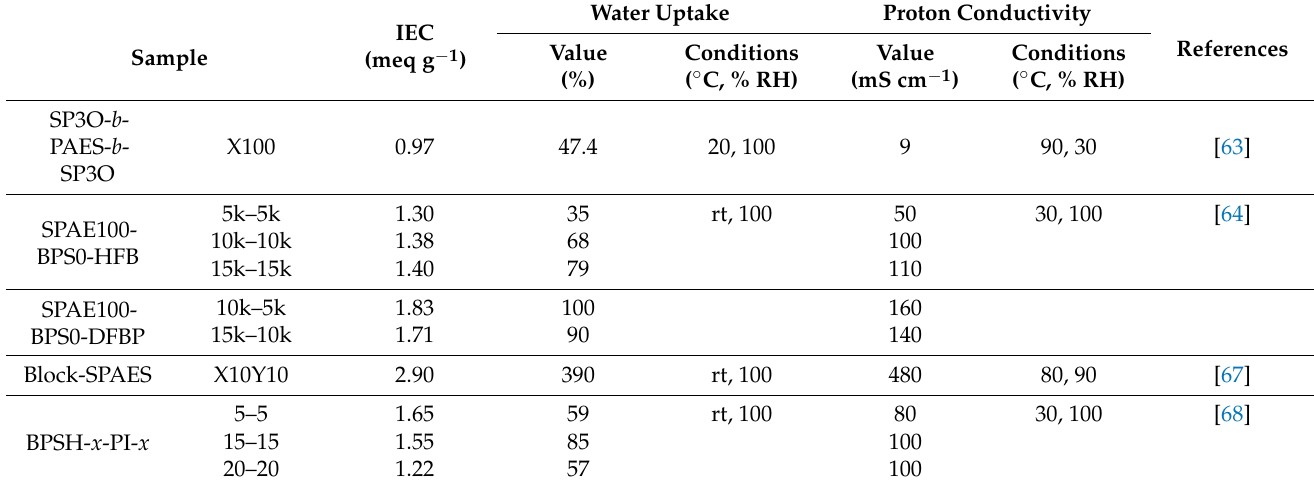
Table 3. Properties of block copolymer-based polymer electrolyte